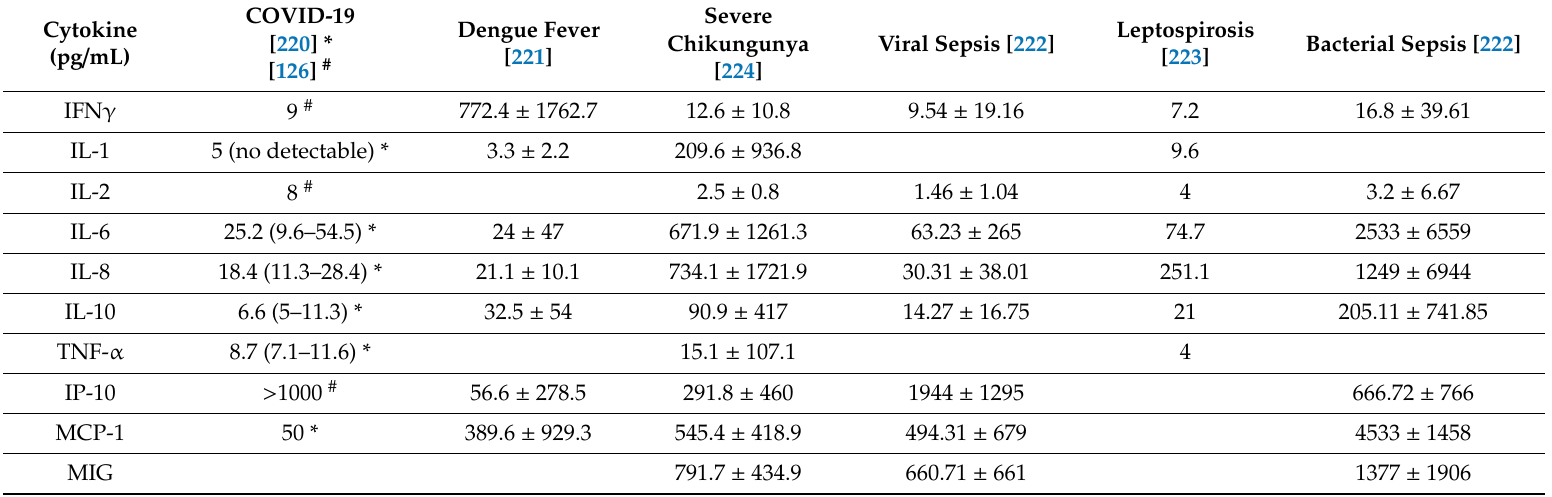
Table 2. Cytokine profile during diverse